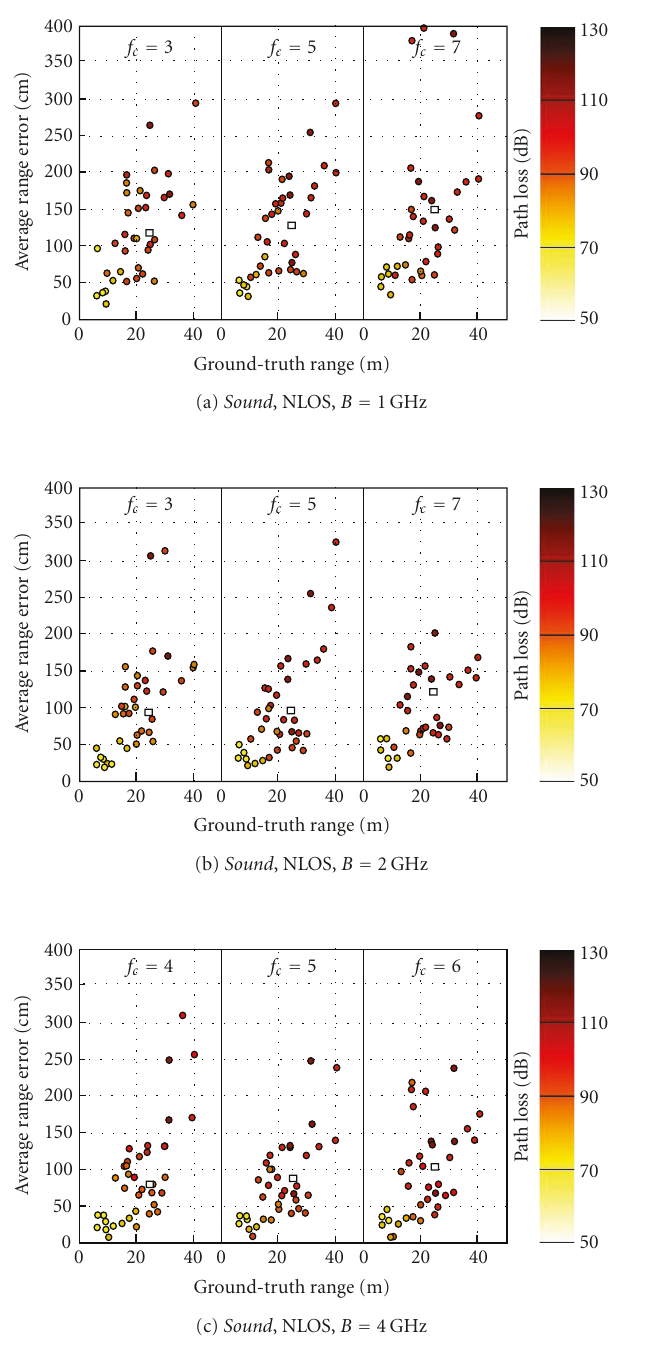
Figure 7: Range error (cm) versus ground-truth range (m) while varying center frequency f c (GHz) in non-line-of-sight conditions.